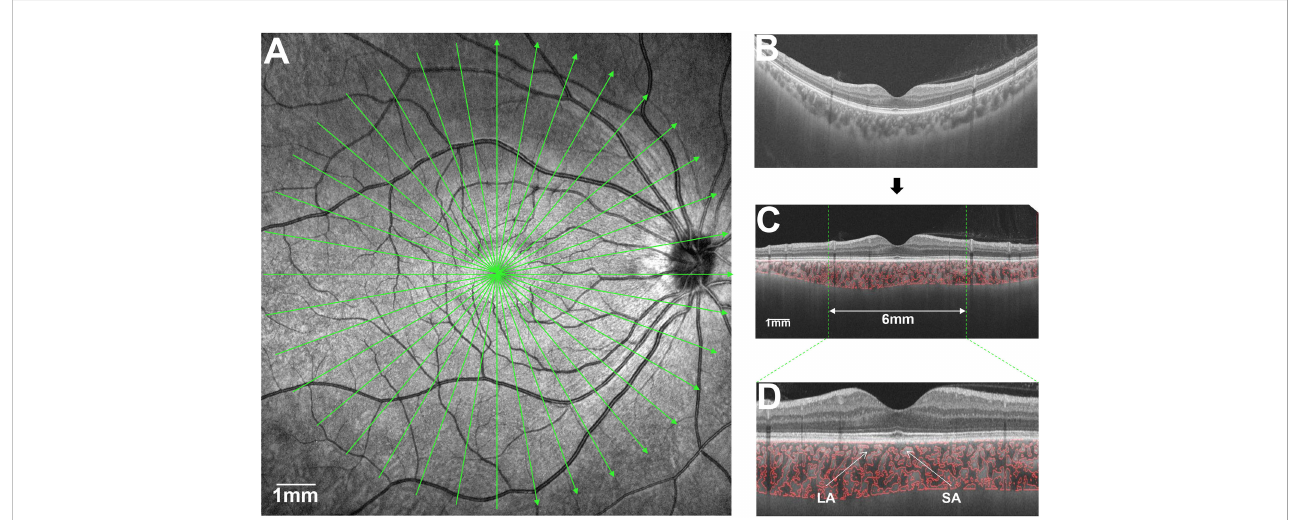
FIGURE 1 Illustration of choroidal analysis. (A) , scan range of choroid within 12 mm with 18 radial lines; (B) , Raw images of the choroid; (C) , Choroidal vascular and stroma image is fl attened; (D) , Magni fi ed Choroidal vascular and stroma imagein 6